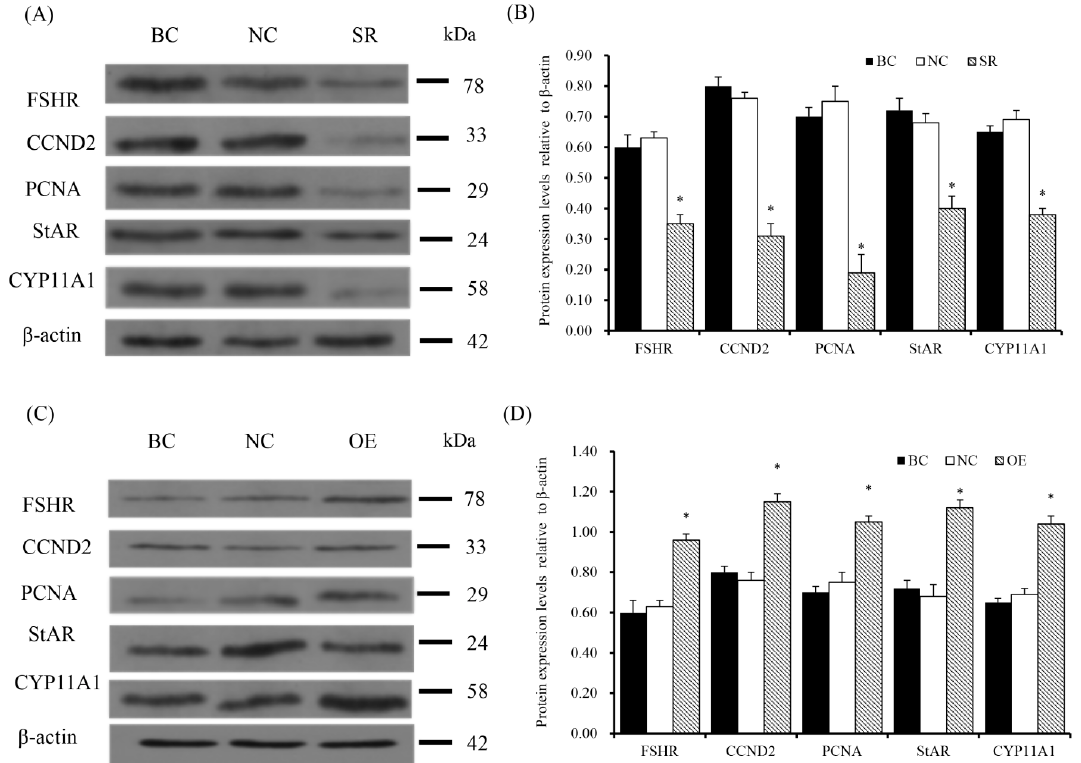
Figure 8. Rac1 prompts protein expression of FSHR, CCND2, PCNA, StAR and CYP11A1. ( A , B ) Expression of FSHR, CCND2, PCNA, StAR and CYP11A1 proteins after RAC1 specific siRNA transfection in GC. The loading control used was β -actin. The gels were run and all the blots were cropped under the same experimental conditions. ( C , D ) Expression of FSHR, CCND2, PCNA, StAR and CYP11A1 proteins after pYr-adshuttle-4- RAC1 vector transfection in GC. β -actin was used as the loading control. Data represent means ± SEM ( n = 10). Bars with superscripts suggest the statistically noteworthy difference in comparison to the control groups (* p < 0.05).